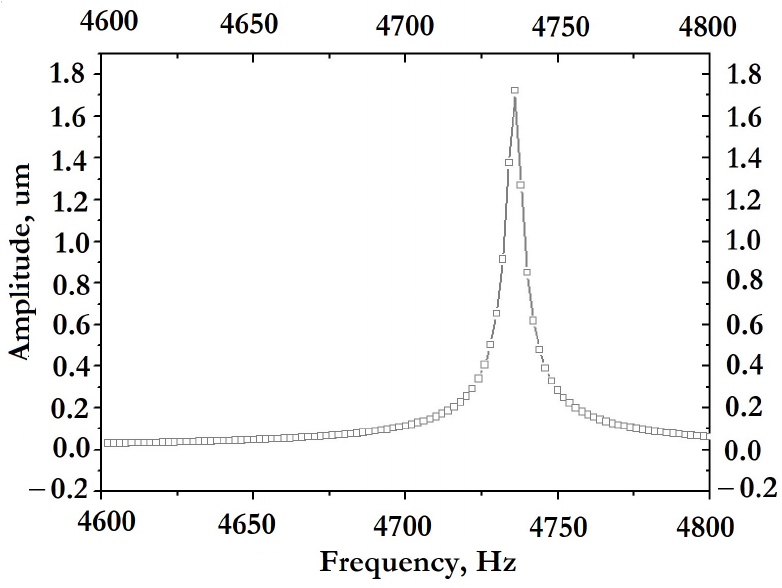
shown in Figure 24 was obtained.